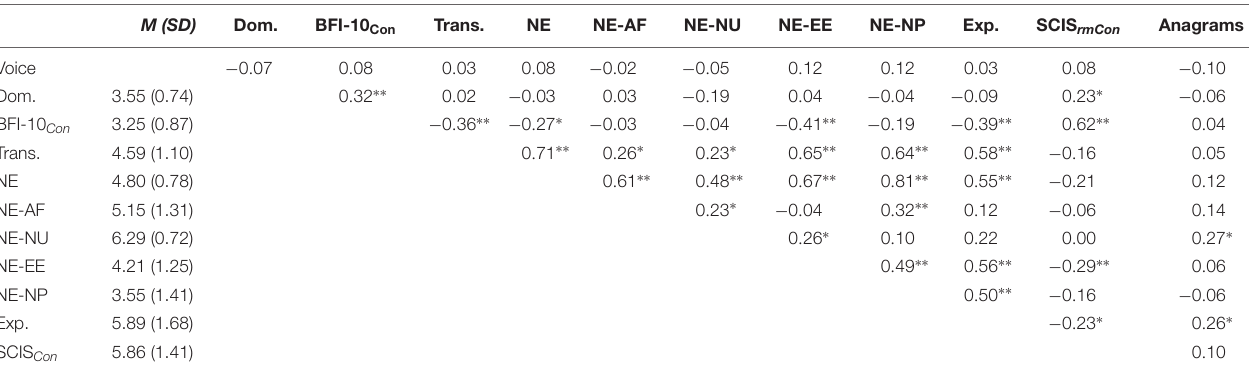
TABLE 3 | Correlations among variables and descriptive statistics (Study 2).